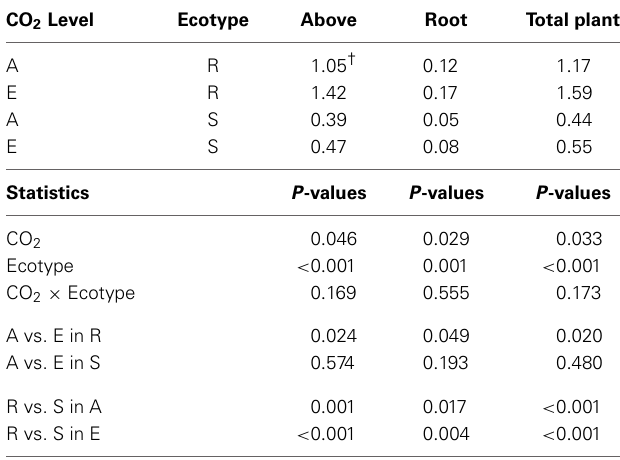
Table 1 | The response of two ecotypes (R = Resistant; S = Susceptible to glyphosate) of common ragweed plant component part dry weight to ambient (A = 375 µ mol mol − 1 ) and elevated (E = ambient + 200 µ mol mol − 1 ) CO 2